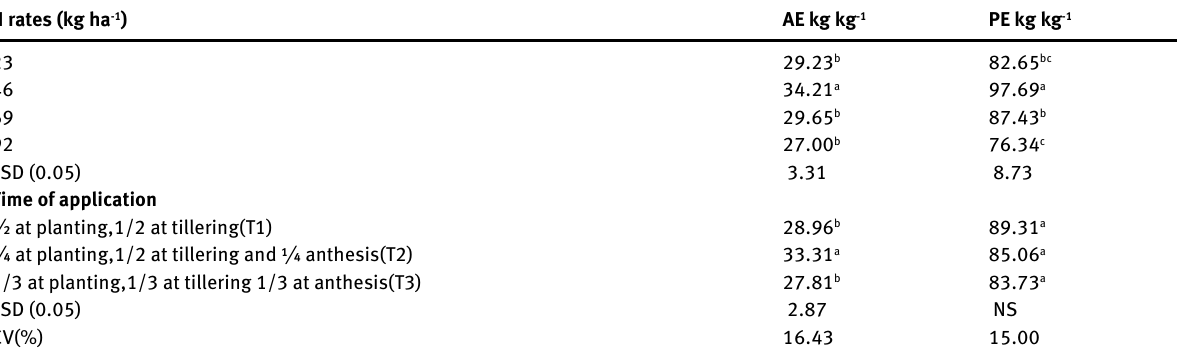
Means of the same parameter in a column followed by the same letter are not significantly different at P = 0.05 according to LSD Fishers Protected Test. AE = agronomic efficiency, PE = physiological